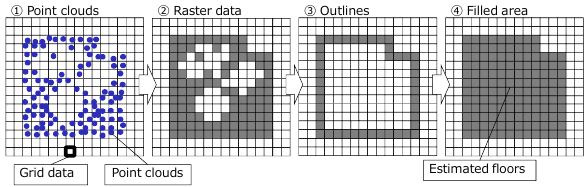
horizontal axis indicates a section direction, and the vertical axis indicates the number of accumulated point clouds in each grid. The bottom image in Figure 4 shows a section of the DSM. The horizontal axis indicates a section direction, and the vertical axis indicates the height value of the highest point in each grid.